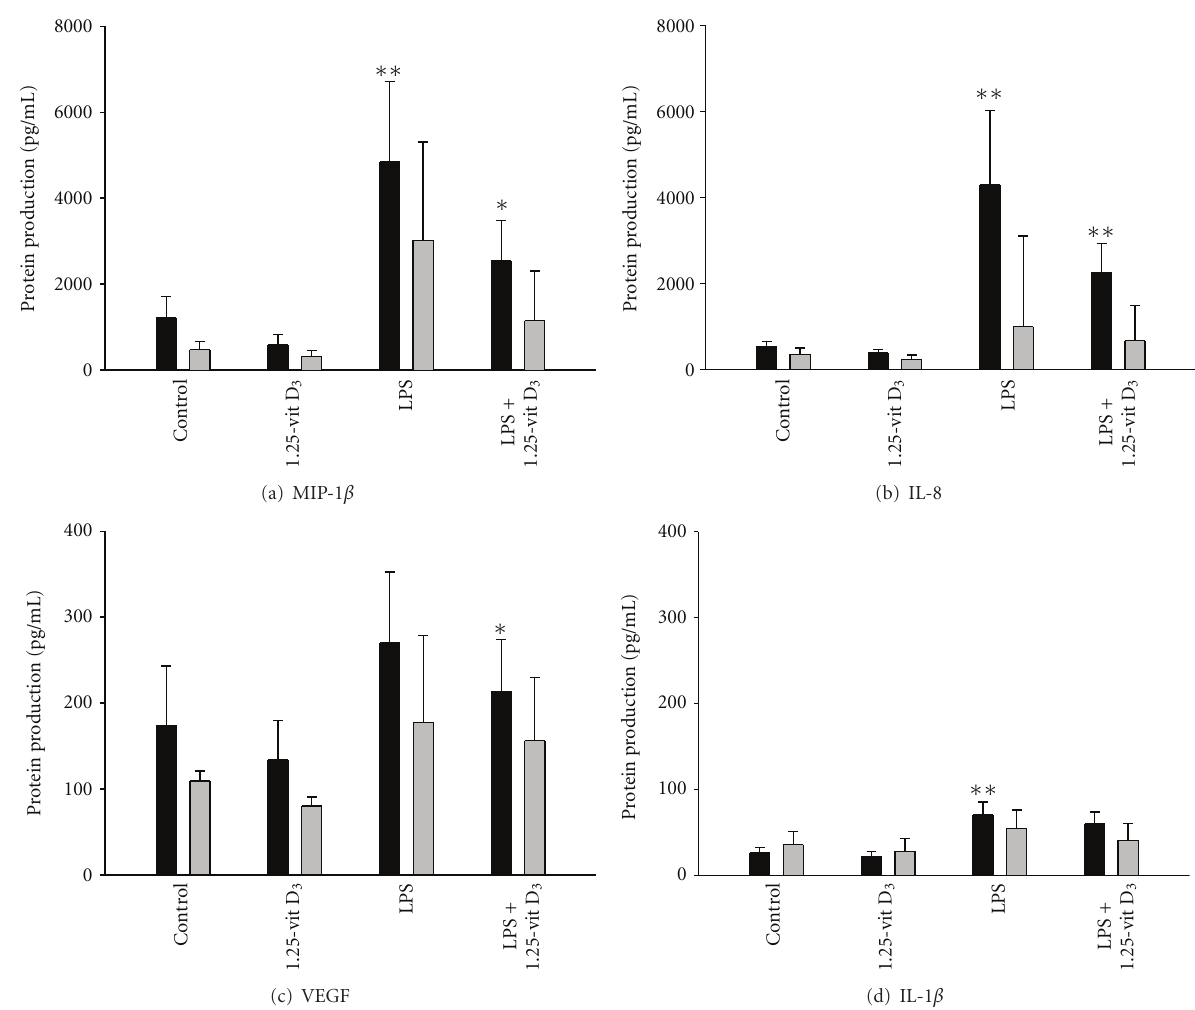
Figure 2: E ff ects of MEHP on inflammatory mediator production. Adult (black column) and neonatal (grey column) neutrophils were incubated in the presence or absence of LPS (1 μ g/mL) and/or 1,25-Vit D 3 (10 − 7 M) for 24 h. The inflammatory mediators (a) MIP-1 β , (b) IL-8, (c) VEGF, and (d) IL-1 β were measured in culture supernatants using cytometric bead array analysis. Each bar represents the mean ± SE ( n = 4–11). ∗ Significantly di ff erent ( P < 0 . 05) from LPS; ∗∗ significantly di ff erent ( P < 0 . 05) from